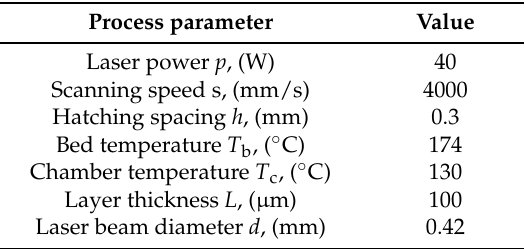
Table 1. SLS (selective laser sintering) parameters for PA12 and CNTs/PA12 powders.